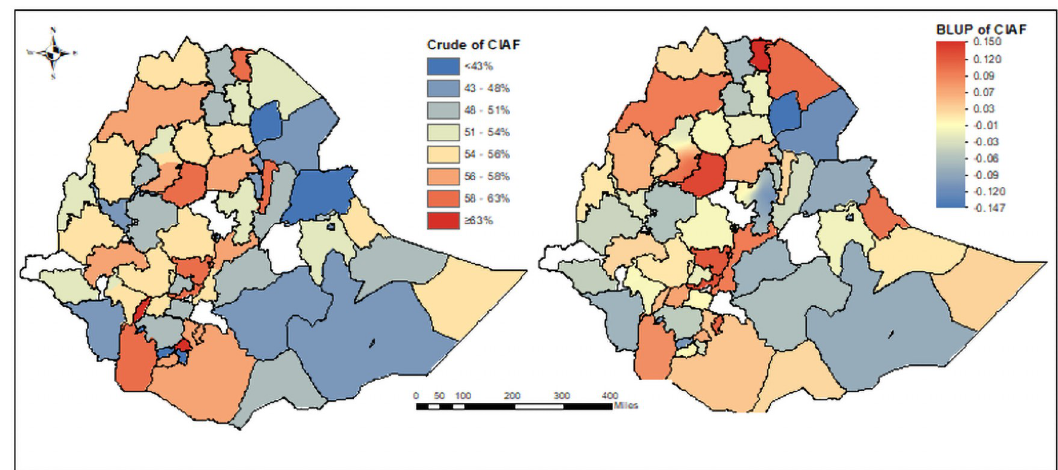
Fig 6. The crude and estimated CIAF among U5C in Ethiopian administrative